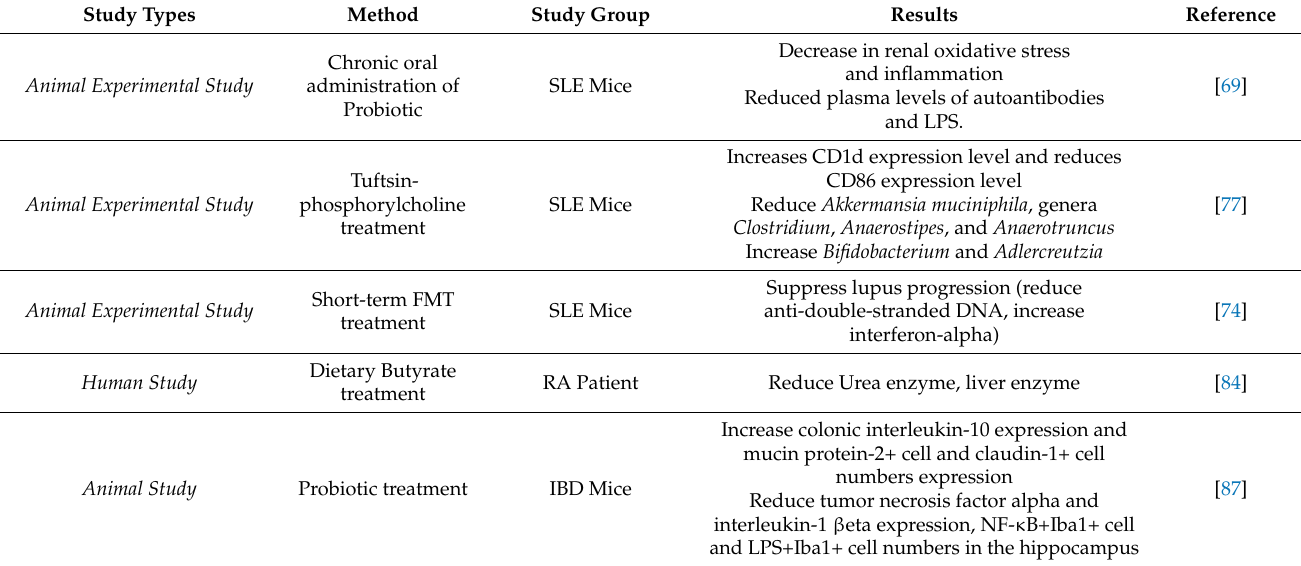
Table 2. The potential treatment of Lupus Nephritis in animal